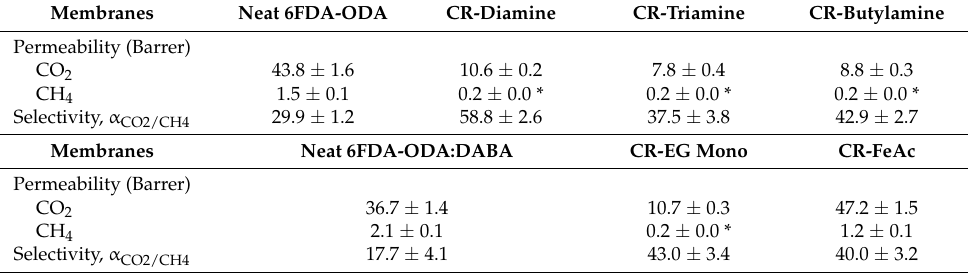
Table 2. CO 2 and CH 4 permeabilities and CO 2 /CH 4 selectivity of the neat 6FDA-ODA and 6FDA-ODA:DABA and their crosslinked membranes, measured at 25 ◦ C, feed pressure at 4 bar with an equimolar binary mixture of CO 2 and CH 4